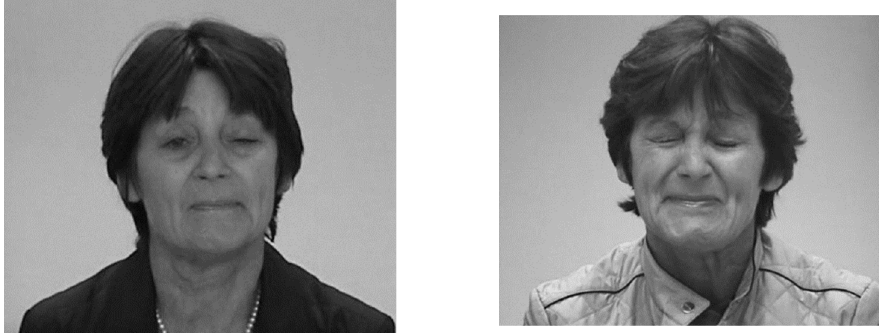
Figure 1. This patient suffers from “retrocollis and retrocaput” (left side). One week after injection of a low dose (100 U) of abobotulinumtoxinA (Dysport ® ), she experienced severe neck weakness and a dropped head.